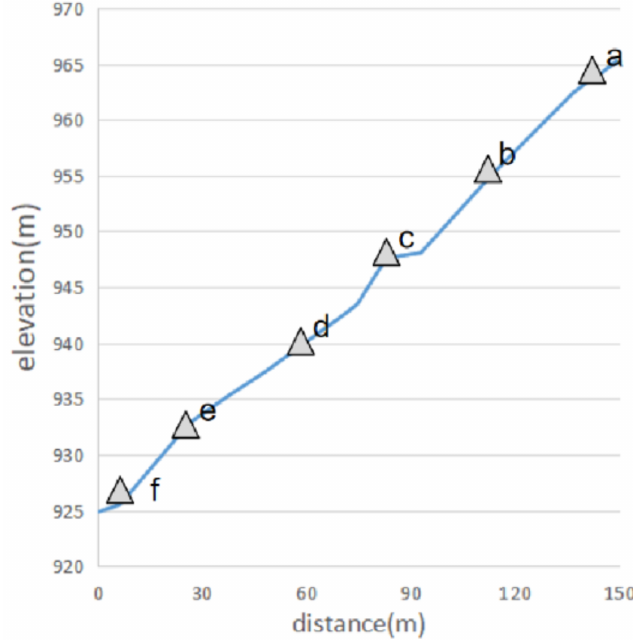
Figure 7. Elevation of measuring position in FFD02 (Maliu